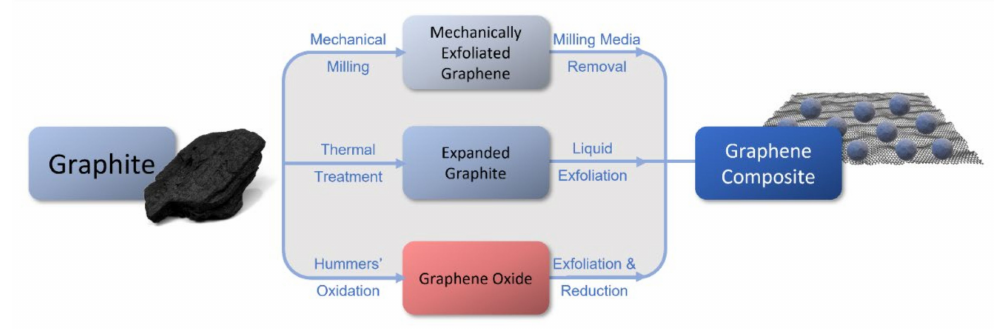
Figure 3. Scalable synthetic routes of graphene-composite